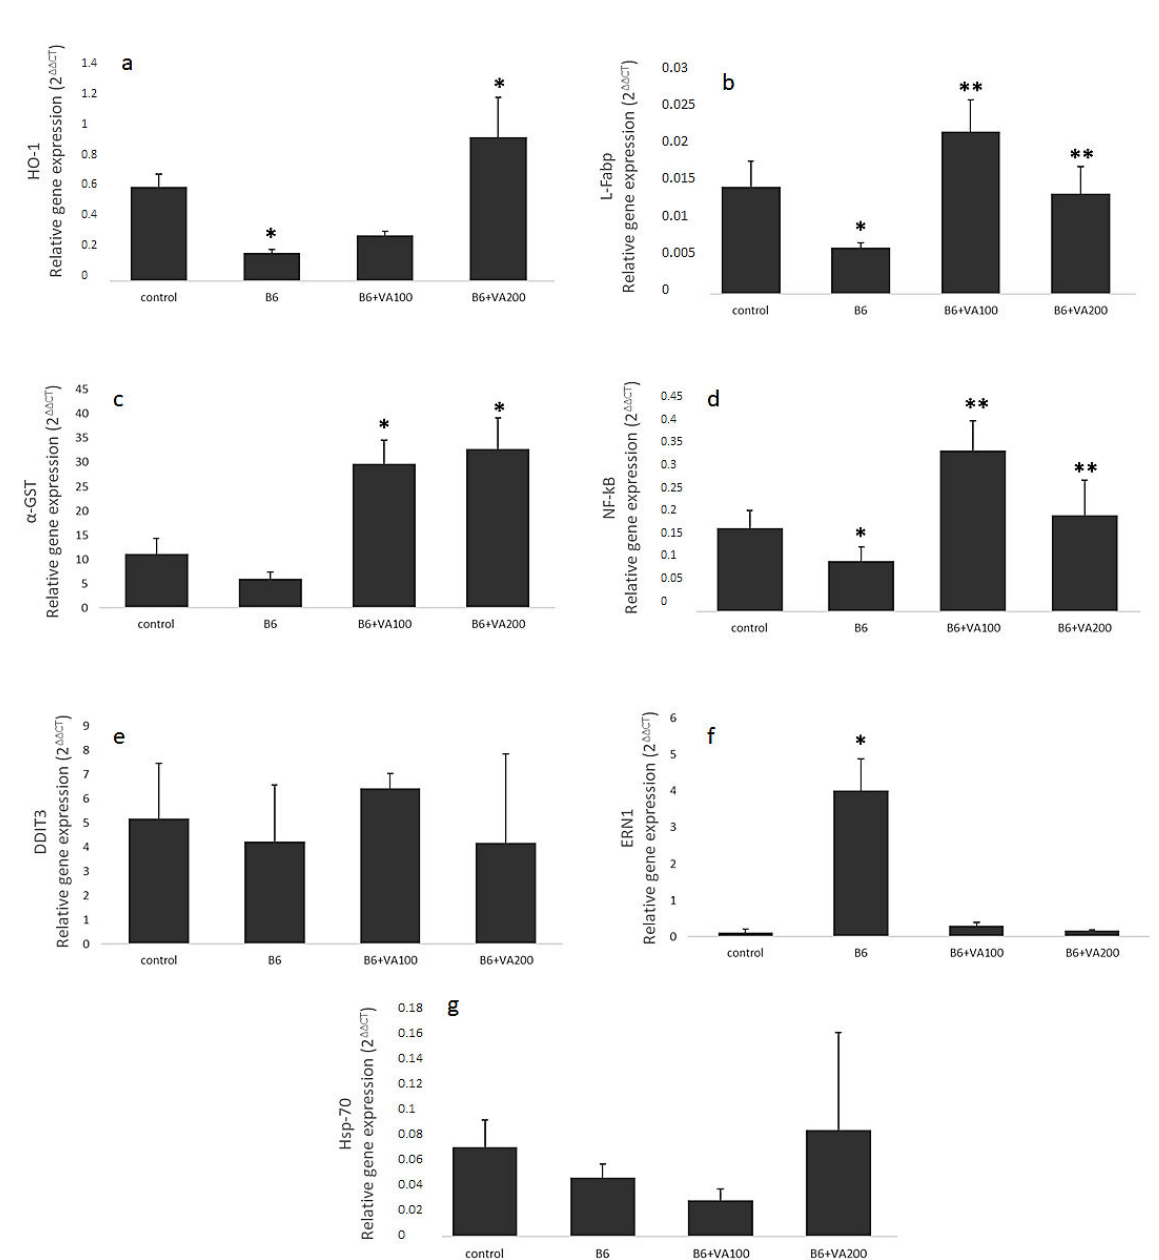
Figure 7. The effects of benomyl and benomyl accompanied by two concentrations of VA (100 and 200 µ M) on the relative gene expression levels of oxidative stress and endoplasmic reticulum stress-related molecules of the cells; ( a ) HO-1: heme oxgenase-1; ( b ) L-Fabp: liver-type fatty acid-binding protein; ( c ) a-GST: a-glutathione-S transferase; ( d ) NF- κ B: nuclear factor kappa-light-chain-enhancer of activated B cells; ( e ) DDIT3: human DNA damage inducible transcript 3 protein; ( f ) ERN1: human endoplasmic reticulum to nucleus signaling 1; ( g ) Hsp70: heat shock protein 70. B6: exposure to 6 µ M benomyl; VA100: exposure to 100 µ M valerenic acid; VA200: exposure to 200 µ M valerenic acid (* statistically significant difference compared to the control; ** statistically significant difference compared to the B6